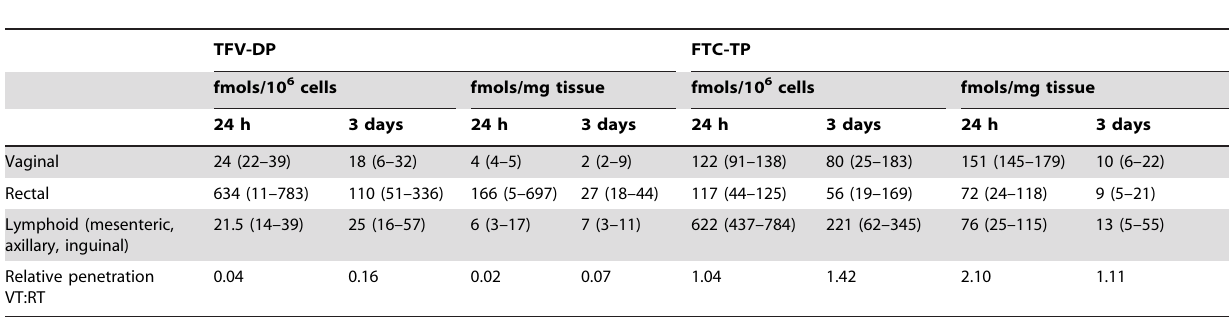
Table 1. Intracellular TFV-DP and FTC-TP concentrations at 24 h and 3 days in vaginal, rectal, and lymphoid tissue after a single oral